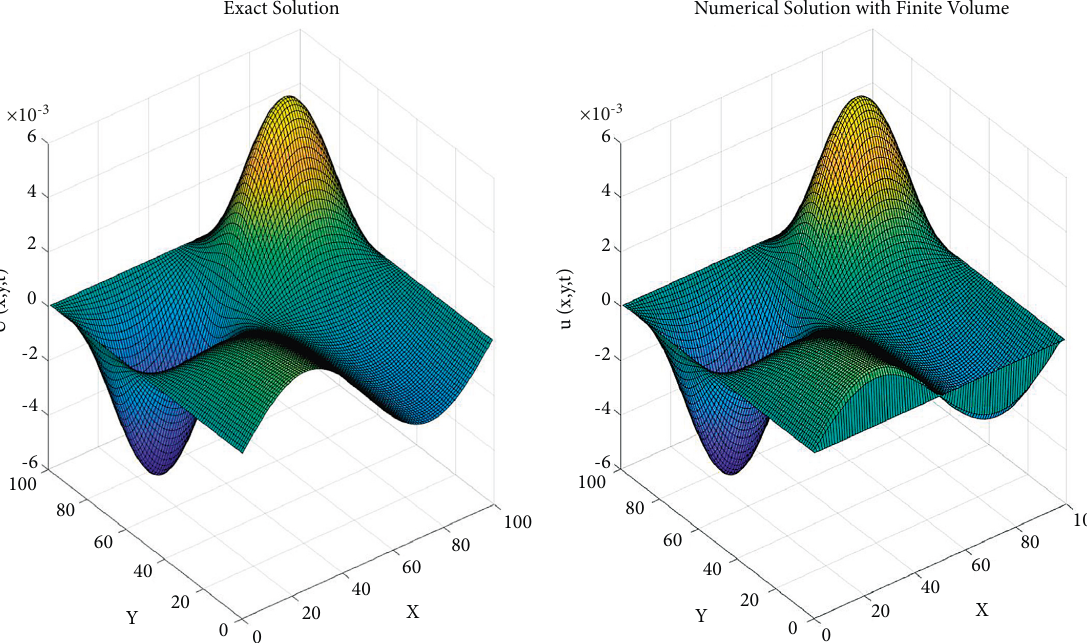
Figure 9: Analytical and approximate results of FVM at 100 × 100 grid size, time step � 0 . 01, and ϵ � 0 .